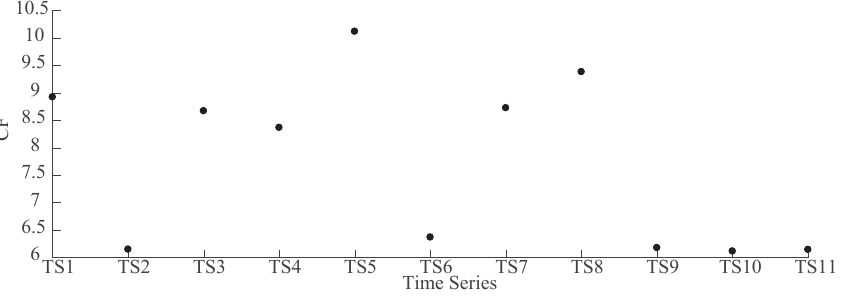
Figure 12. Overall Crest Factor (CF) values of the instantaneous phases of the first three harmonics of the planetary gear meshes.